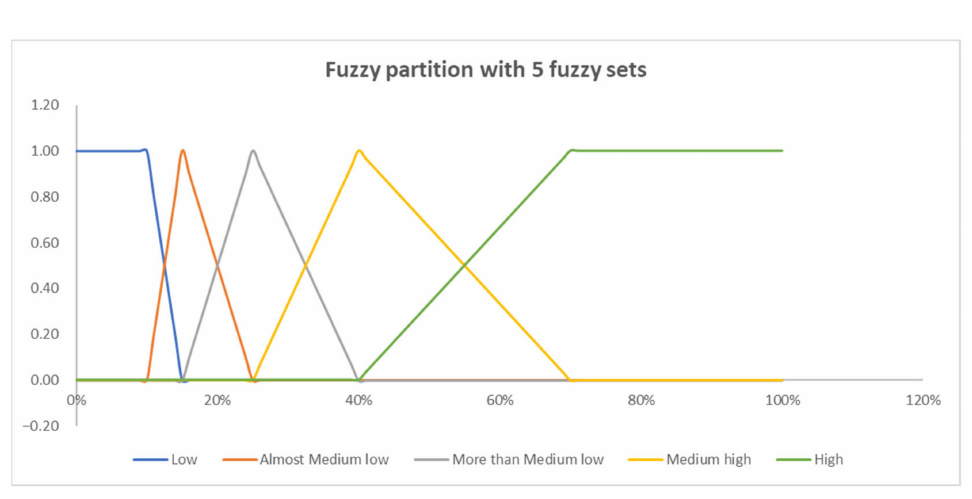
Figure 5. Final fuzzy partition with 5 fuzzy